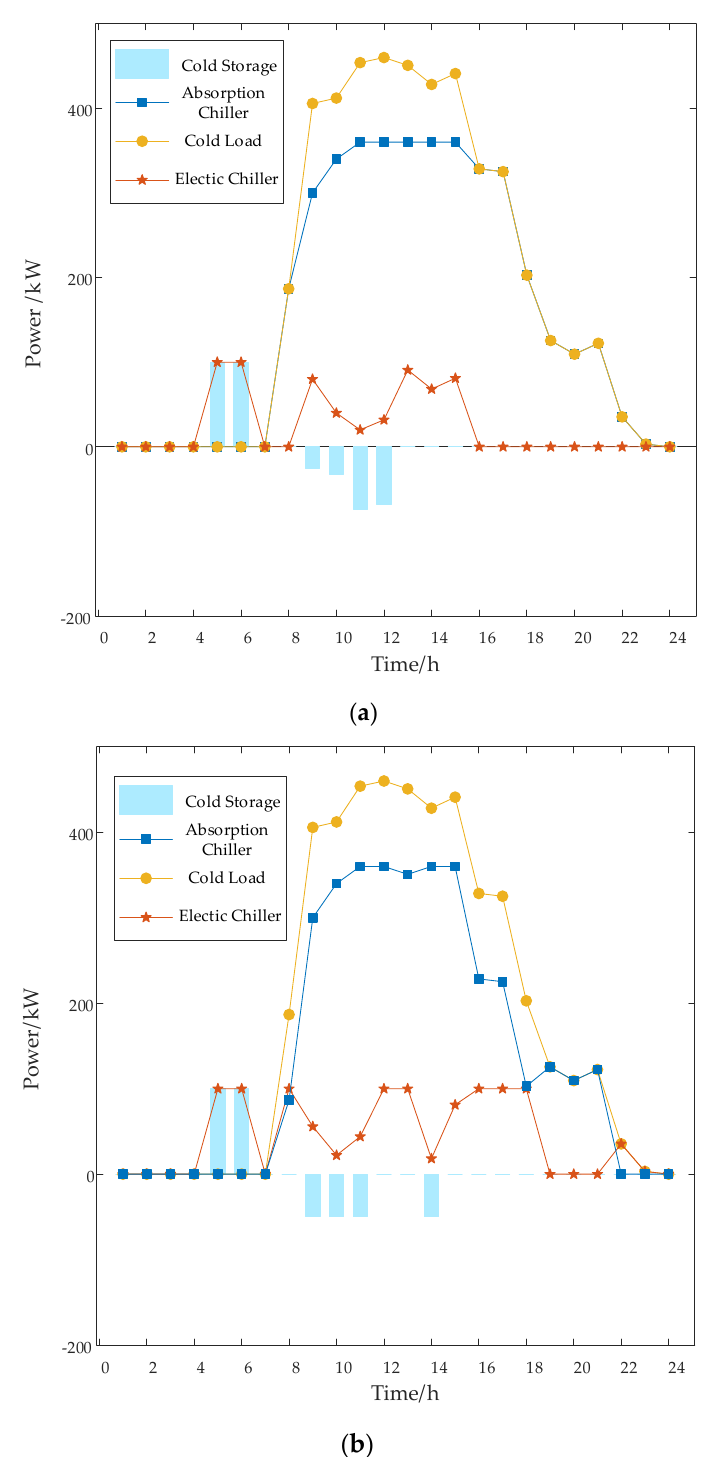
Figure 4. The power output on the electric bus before and after optimization: ( a ) before optimization; ( b ) after optimization.